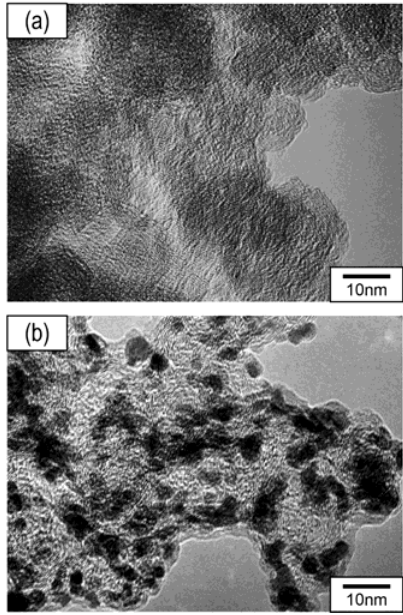
Figure 2. Transmission electron microscope (TEM) images of carbon black ( a ) before; and ( b ) after the in-liquid plasma process was carried out for 20 min.